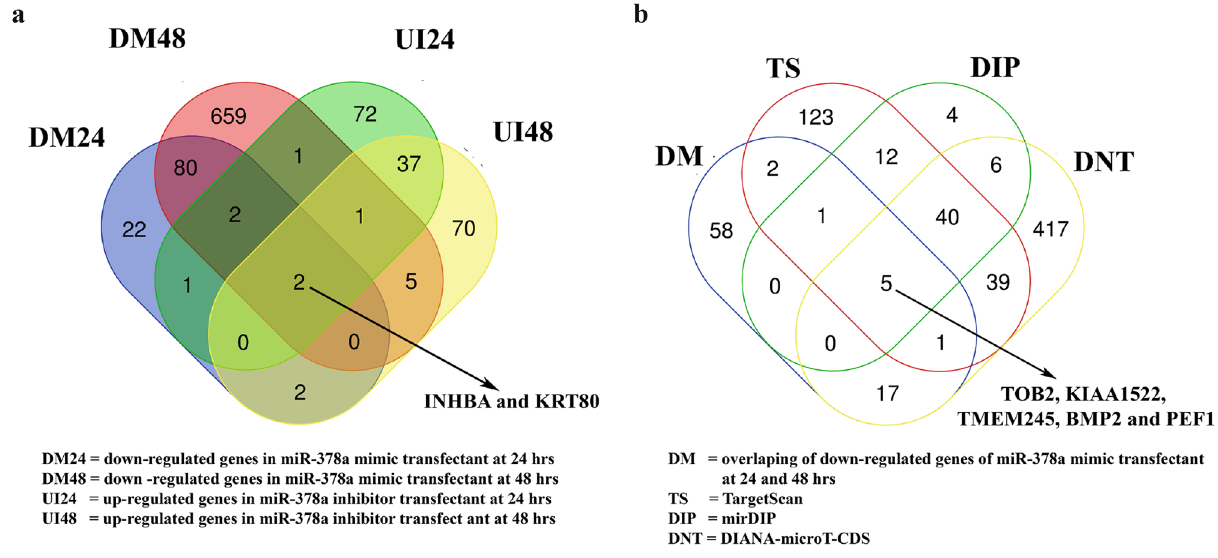
Figure 5. Identification of candidate gene targets of miR-378a. ( a ) Venn diagram shows the overlaps of genes down-regulated (DM) in cells transfected with miR-378a mimic for 24 h and 48 h and genes up-regulated (UI) in cells transfected with miR-378a inhibitor for 24 h and 48 h. ( b ) Venn diagram shows the overlaps of genes identified in ( a ) and target genes of miR-378a predicted by three different databases (see “Materials and methods”